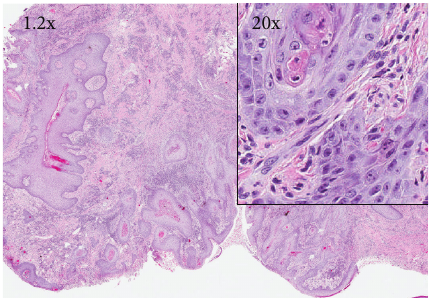
Figure 2: Hematoxylin-eosin stain (1.2x and 20x (right inset)) of scrotal lesion revealing well-differentiated squamous cell carcinoma with submucosal invasion and focal keratinization.